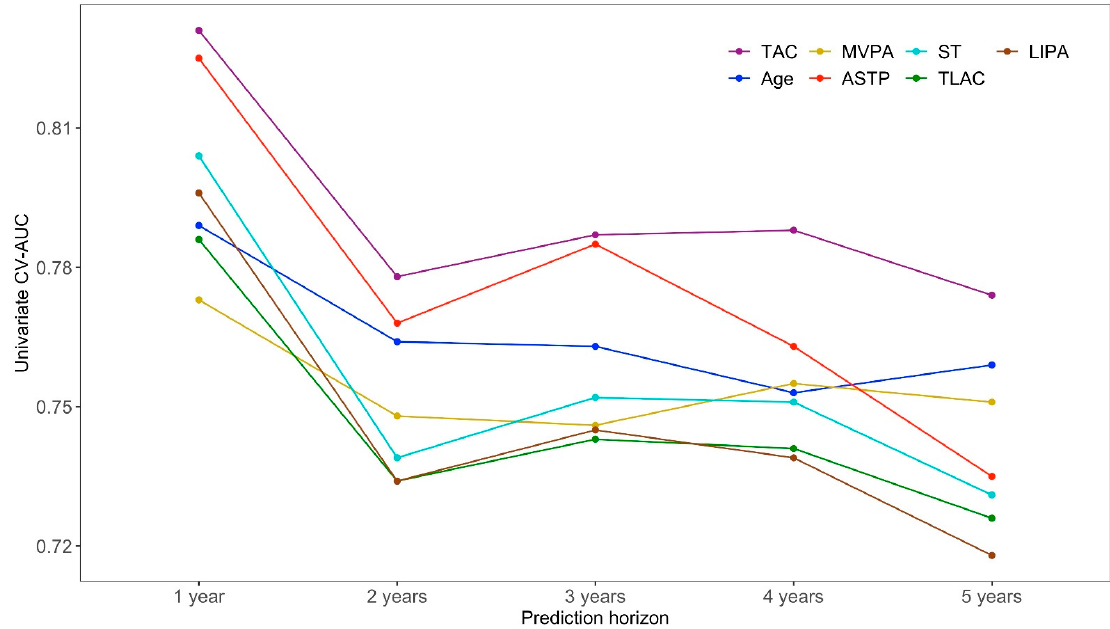
Figure 1. The cross-validated area under the curve (CV-AUC) values for the top seven predictors in the univariate five-year all-cause mortality logistic regression models across one- to five-year mortality prediction horizons. The x-axis corresponds to the prediction horizon and the y-axis is the CV-AUC (higher indicates better prediction performance).